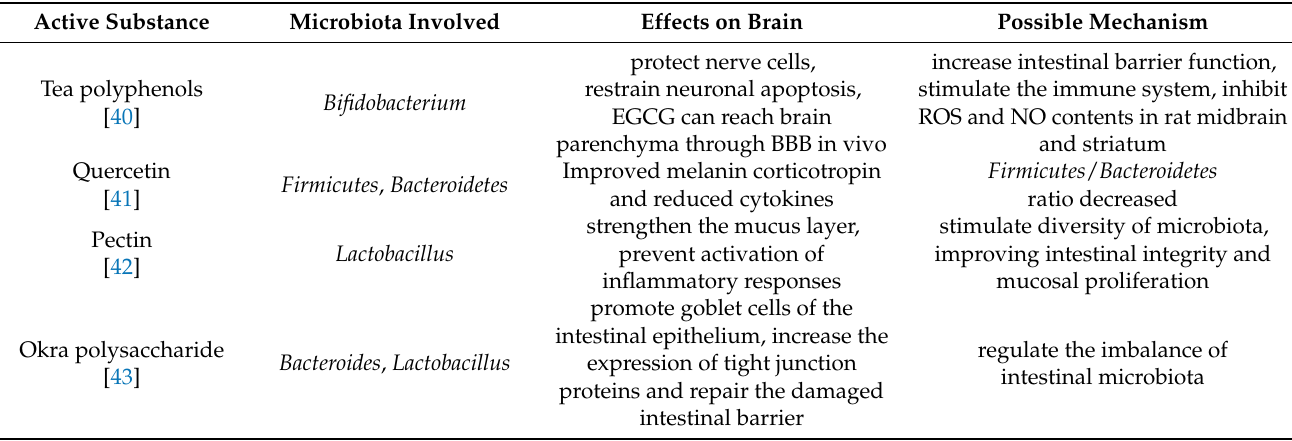
Table 1. Summary of the modulatory effects of prebiotics on microbiota and